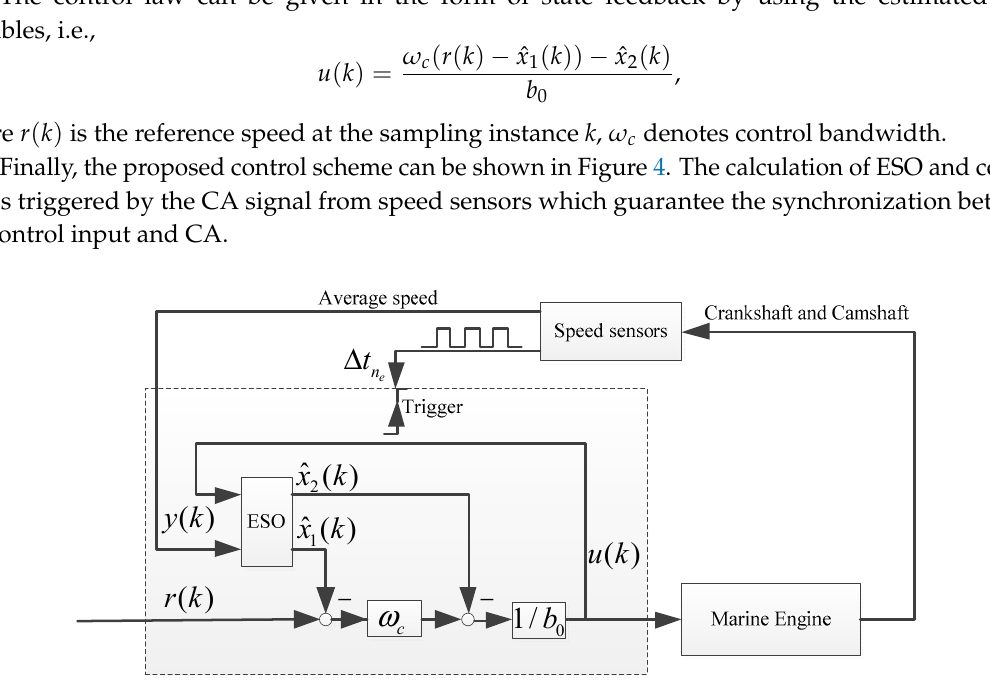
Figure 4. The block diagram of the variable sampling rate Active Disturbance Rejection Control (ADRC) for marine engine speed control.